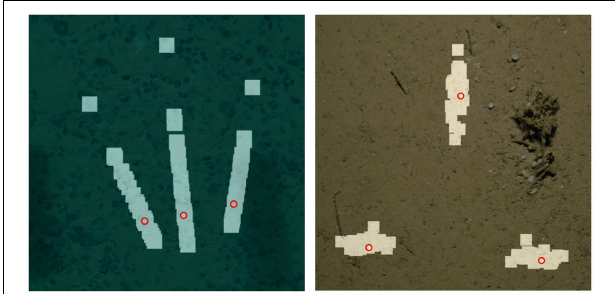
FIGURE 3 | Examples for two different LP spatial layouts with detection masks (highlighted parts), corresponding to 90 annotated LPs each. The left part shows the spatial layout for T1, the right part for T2. Both cases show an example of a successful detection where the detected LP positions are given as red circles.